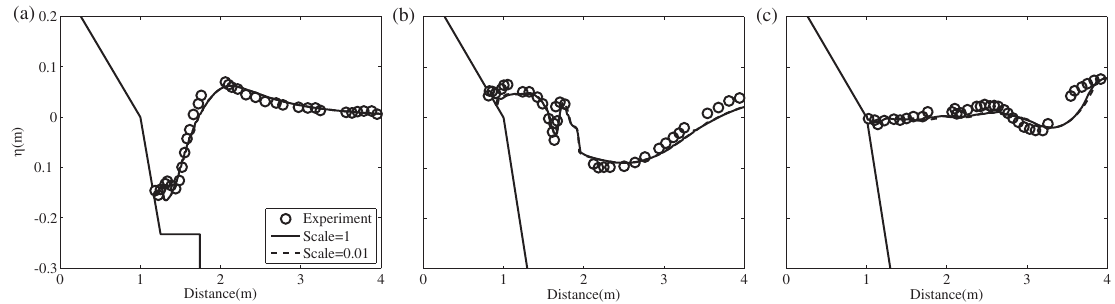
Figure 4. Comparison between numerical and experimental wave profiles in the near field: ( a ) t = 0.5 s; ( b ) t = 1.5 s; and ( c ) t = 3